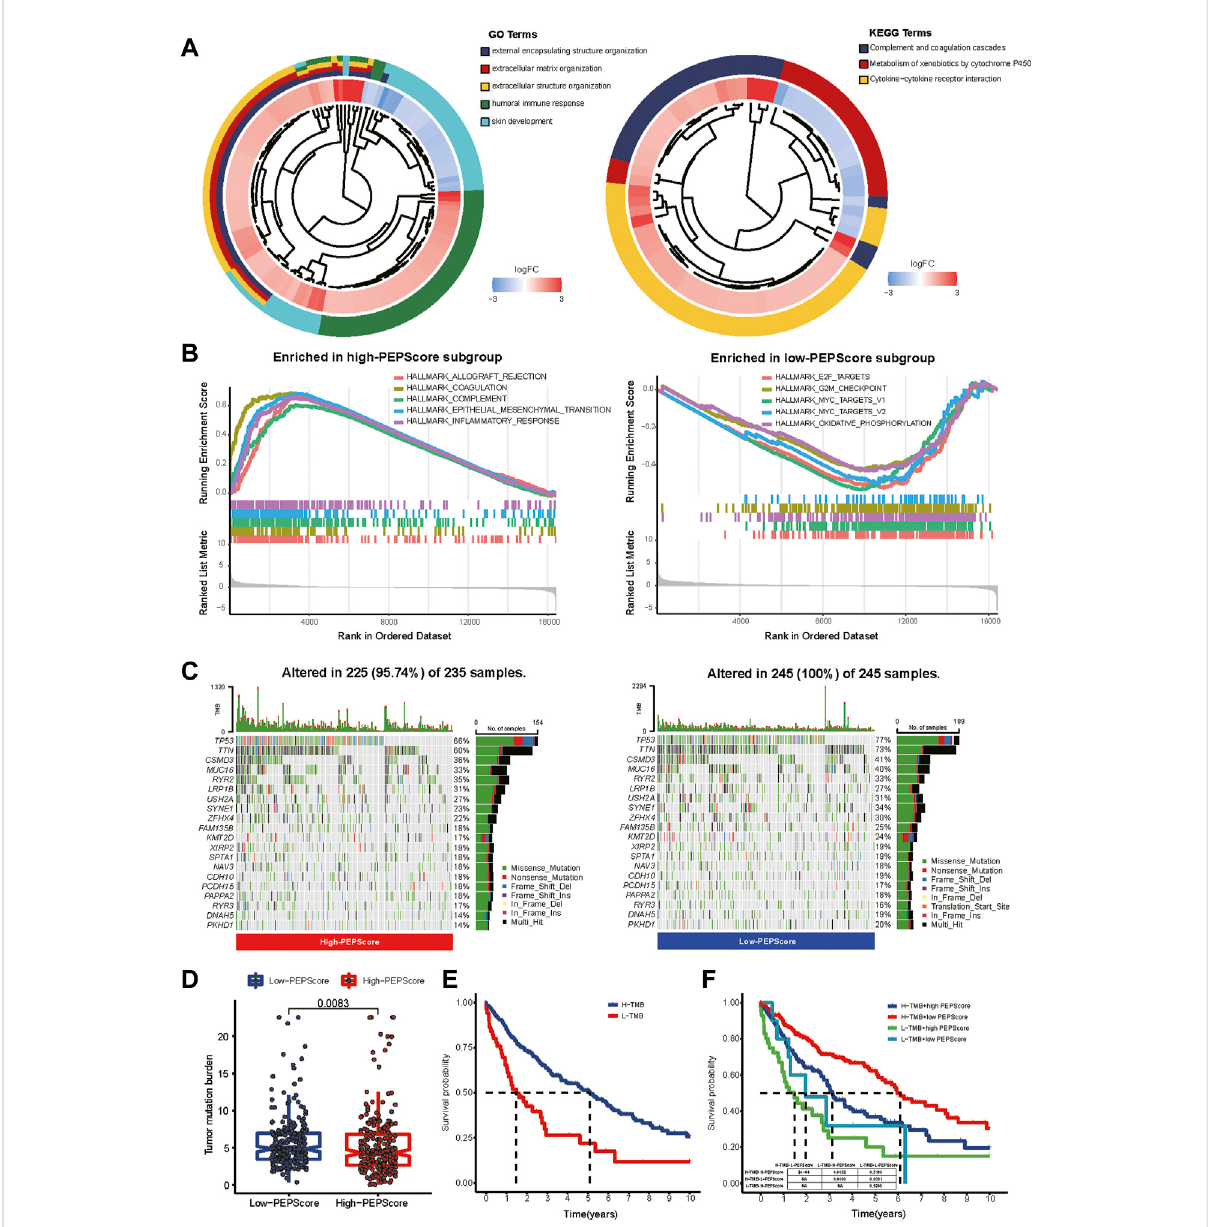
FIGURE 4 Comprehensive analysis of molecular and tumor-microenvironmental characteristics in PEPScore subgroups. (A) GO and KEGG analysis for revealingthepotentialregulatorymechanismsunderlyingthedifferenceofPEPScoreindifferentsubgroups.Atotalof821DEGswereobtainedfrom differential expression analysis between high- and low-PEPScore subgroups. (B) GSEA used on the HALLMARK gene sets to explore the potential mechanismunderlyingthedifferenceofPEPScoreindifferentsubgroups. (C) Top20mutatedmoleculesintheLUSCpatientsinTCGAdatabase ofdifferentPEPScore subgroups. Eachcolumnrepresentsan individual andthemutatedgenesarearrangedbymutation frequency.Thecolorblock indicatesmutationtype,thenumberontherightshowsthemutationpercentage,andthe fi gureaboveshowstheTMB. (D) TMBcalculationtoaccess the quality and quantity of gene mutations in two PEPScore subgroups. (E) The Kaplan-Meier curves with the log-rank test show signi fi cant differences in OS between high and low TMB subgroups. The cut-off value of TMB was 2.105, which was calculated by R package of “ survminer ” . (F) The Kaplan-Meier curves with the log-rank test show signi fi cant differences in OS among LUSC patients with different PEPScore and